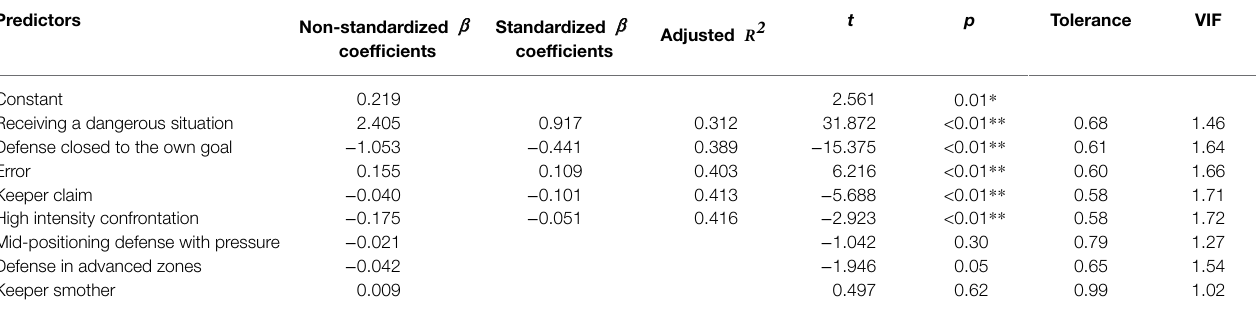
TABLE 3 | Relative contribution of defensive styles of play to the variance of excepted goals (xG) of the opponent frequency.